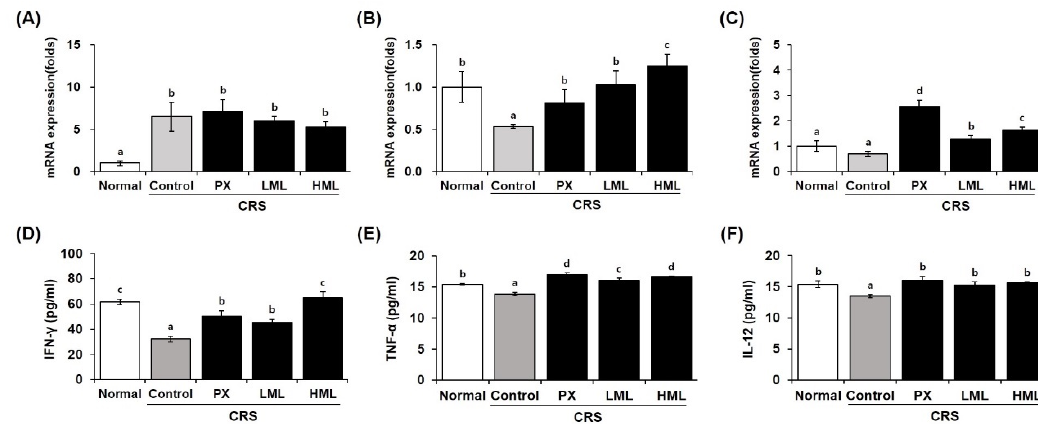
Figure 7. Effect of the ML extracts on anti- and pro-inflammatory cytokine mRNA expression and production in the brain. Mice were restrained for 2 h for 28 consecutive days after the treatments. ( A ) IL-1 β , ( B ) IL-10, ( C ) IL-4, ( D ) IFN- γ , ( E ) TNF- α , ( F ) IL-12. ( A – C ) Cytokine mRNA expression was detected by real-time PCR. ( D – F ) Cytokine production was detected by ELISA kit. Data represent means ± SEM ( n = 5). Different letters (a–d) above the bars indicate significant differences at p < 0.05. CRS—chronic restraint stress; PX—paroxetine; LML—low-concentration mustard leaf; HML—high-concentration mustard leaf.